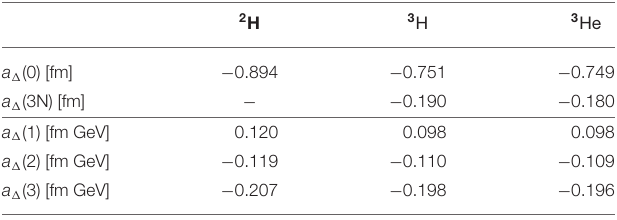
TABLE 12 | Values of the various components of coefficient a 1 as given in Equation (151) in units of e fm for the different